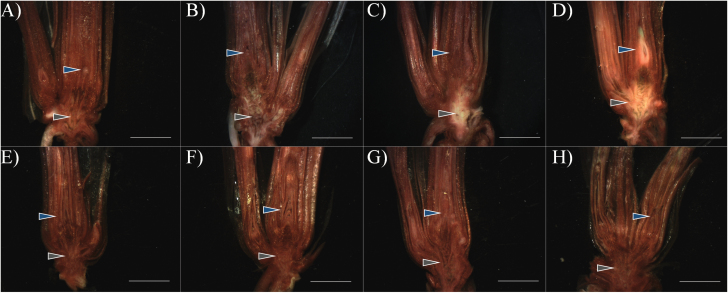
Tetrazolium chloride vital staining of hand-sectioned ‘Norstar’ winter wheat crowns observed after freezing to –12 °C. Plants that were cold acclimated for 42 d were placed in aluminum weighing cans filled with moist sand, held at –4 °C for ice nucleation, then cooled to –12 °C at a rate of –2 °C h−1 (A–D). A subsection of plants were not exposed to freezing temperatures to act as unfrozen controls (E–H). Frozen plants were thawed overnight and then both freeze-exposed and unfrozen controls were planted in potting mix and allowed to recover at 20 °C. Crowns were sampled after 1 (A and E), 3 (B and F), or 7 d (C, D, G, and H) of recovery and stained with tetrazolium. A red color identifies live cells/tissue that can reduce tetrazolium, while the off-white and yellow tissue is injured or dead as a result of freezing. After 7 d post-freezing, two patterns emerge, with either a loss of red coloration in the vascular transition zone (VTZ; C) or a loss of coloration within the VTZ and the shoot apical meristem (SAM; D). Blue arrows indicate the SAM, and gray arrows indicate the VTZ. White scale bar=0.6 cm.